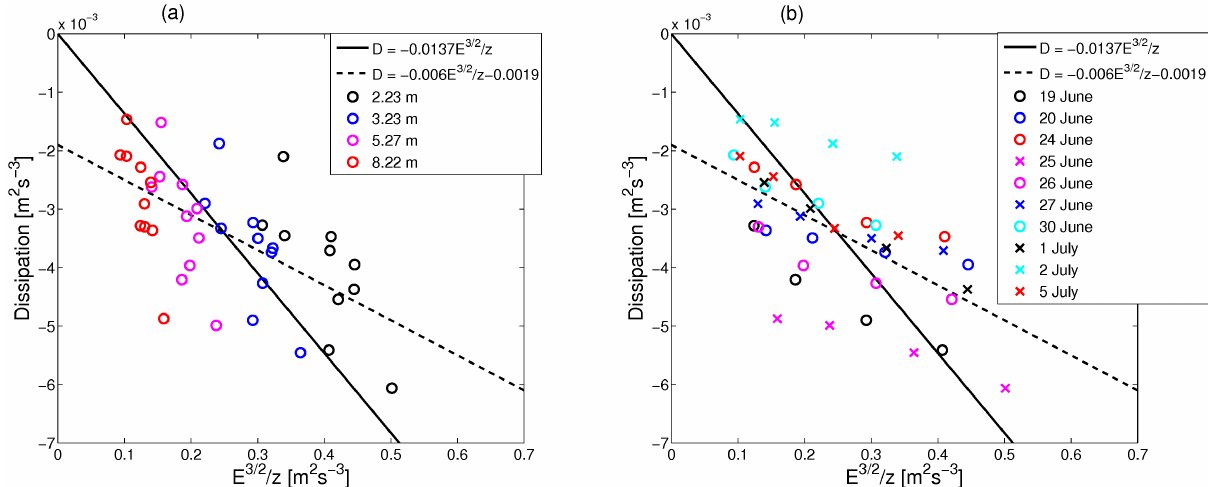
Figure 10. Dissipation is shown as a function of TKE and height near the surface. In panel (a) the four measurement heights 2.23, 3.23, 5.27 and 8.22m have been assigned different colors (black, blue, magenta, red). In panel (b) , instead, each afternoon has been assigned a different color. Two best-fit linear expressions have also been included. The full line expression assumes that the line goes through origin and the dashed line is without this assumption.